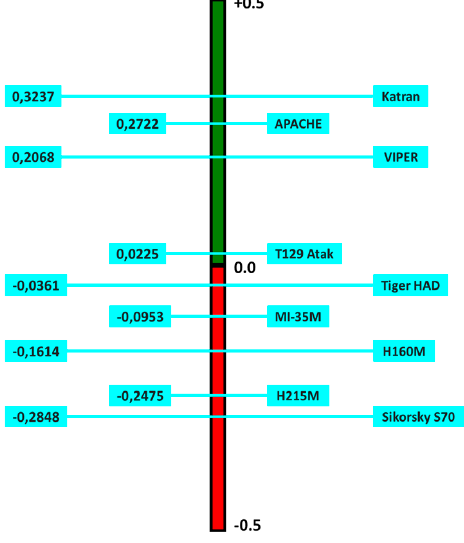
Figure 8. Complete ranking in the PROMETHEE method, adapted from [86].